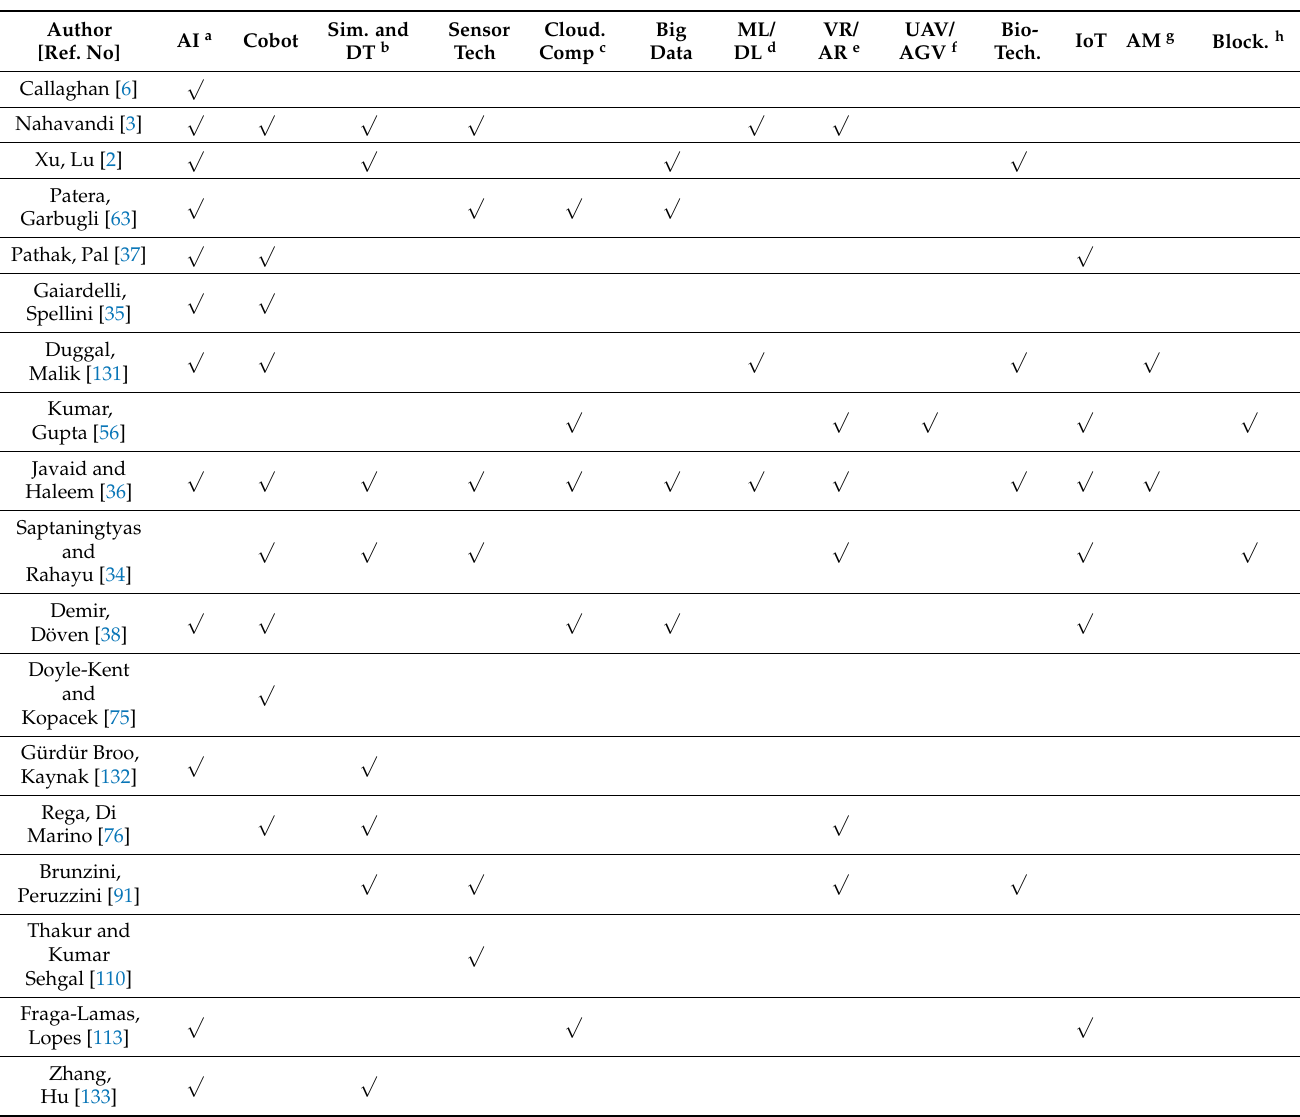
Table A1. Industry 5.0 technologies in smart